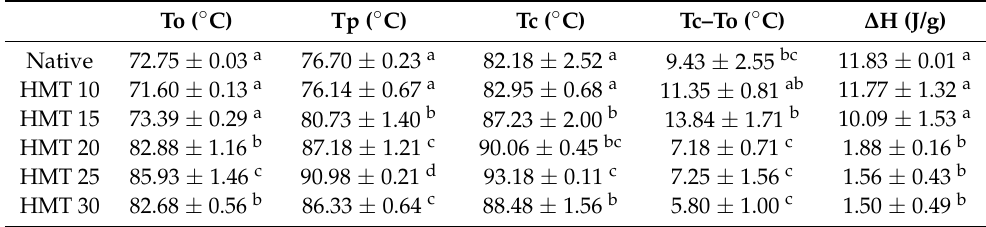
Table 2. Thermal properties of Native and HMT sago starches † .